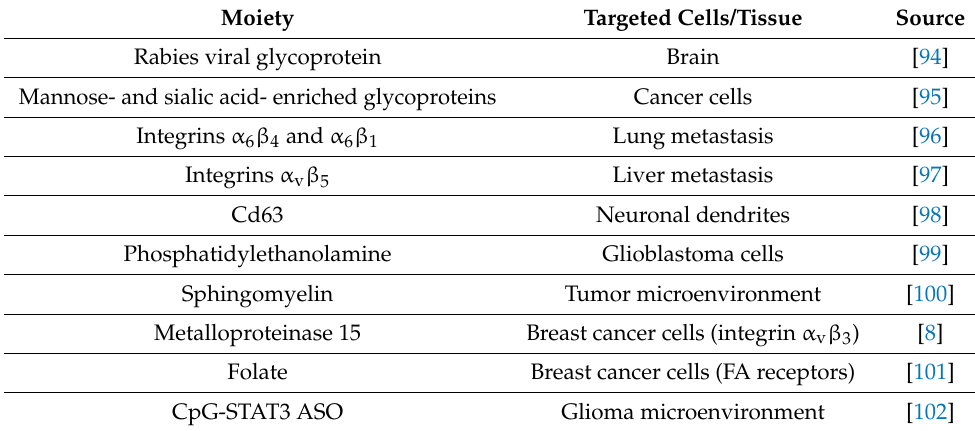
Table 3. Examples of moieties for exosome